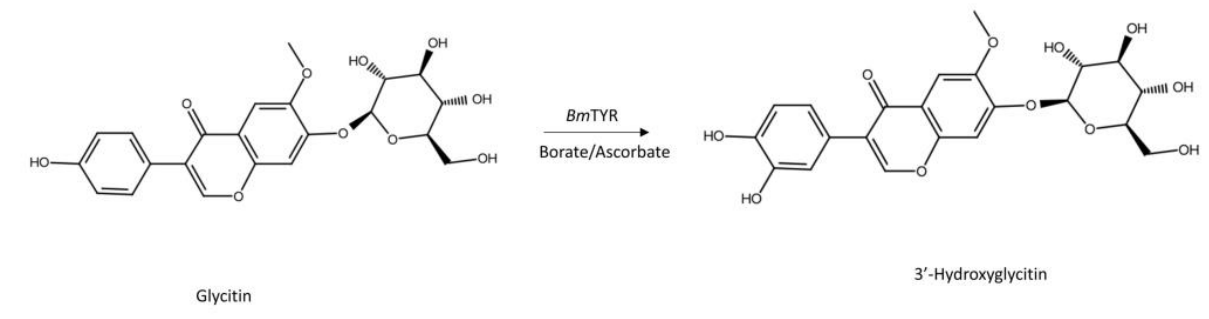
Figure 2. The biotransformation process of glycitin by Bm TYR.